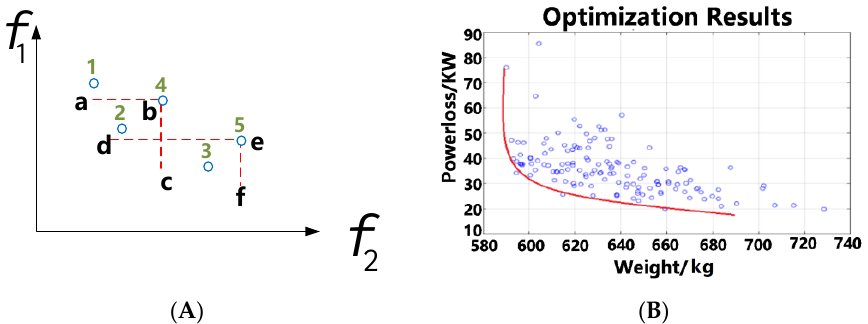
Figure 2. Multi-objective optimization problem. ( A ) Shows values for the two objective functions at five design points. ( B ) The set of GA optimization designs is introduced as the Pareto frontier curve and represents the best collection of design parameter points for aircraft power systems.